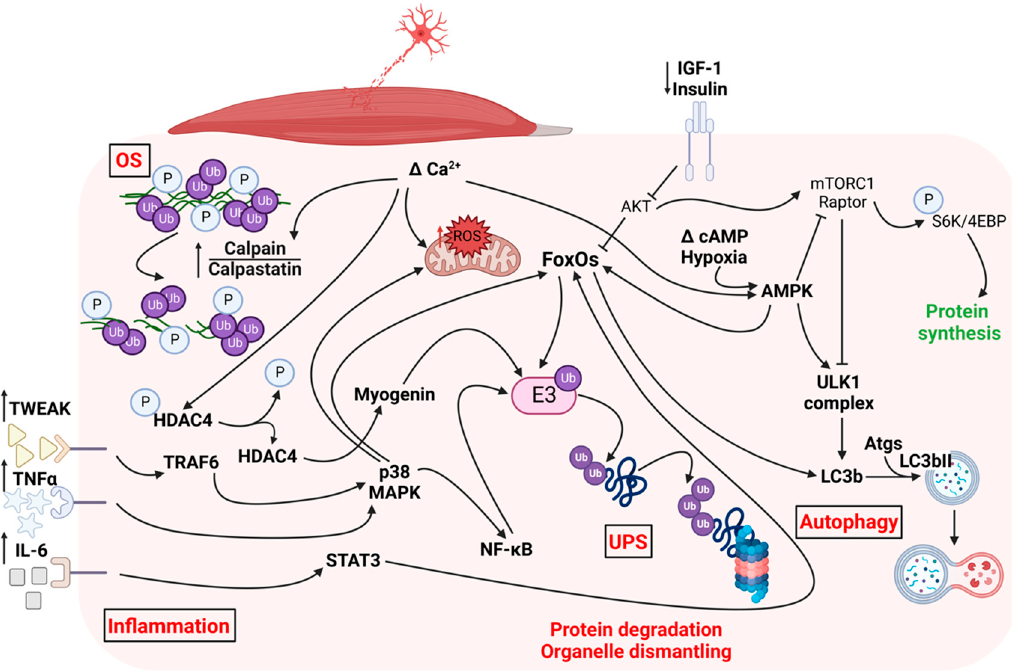
Figure 1. Pathways triggered by denervation in the skeletal muscle. In red are mentioned that one promoting muscle atrophy, while in green the one preserving muscle mass. OS, oxidative stress; UPS, ubiquitin ‐ proteasome system; P, phosphate group, E3, E3 ‐ ubiquitin ligase; Ub, ubiquitin; ∆ , changes.